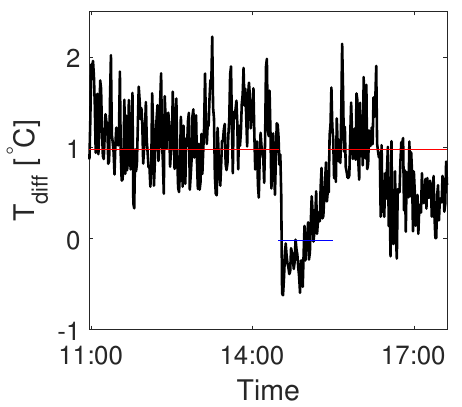
Figure 7. Difference between the temperature measured by the setup at 859 mm and the reference temperature at 1500 mm ( T 859 - T T 1500 ). The red and blue lines show average values for all time steps when the setup was positioned in the sun and in the shade,